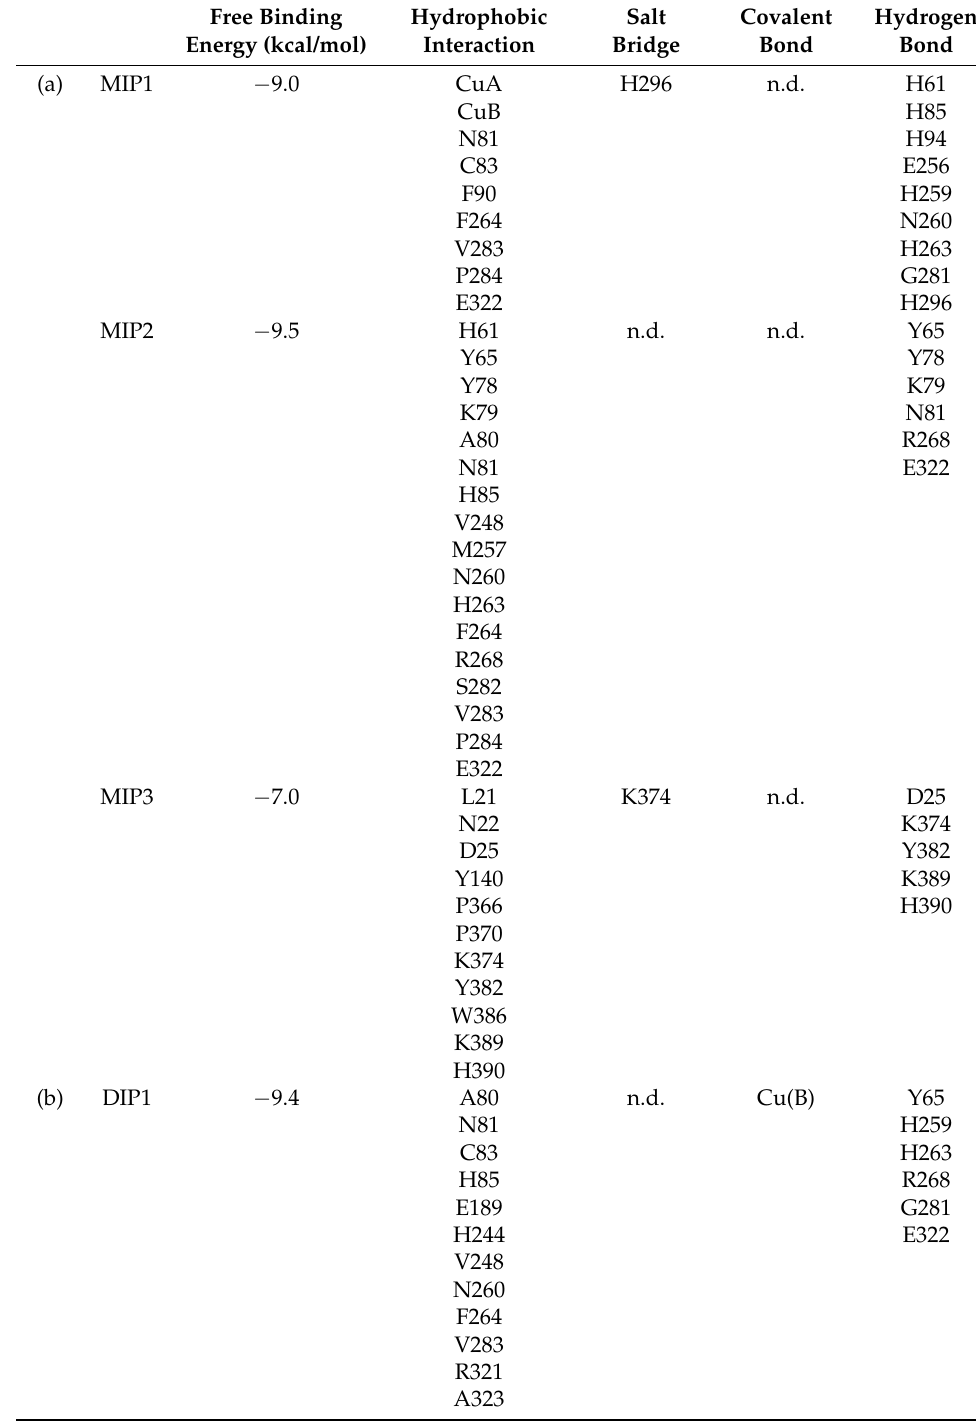
Table 2. Predicted binding interactions of (a) MIPs and (b) DIPs with